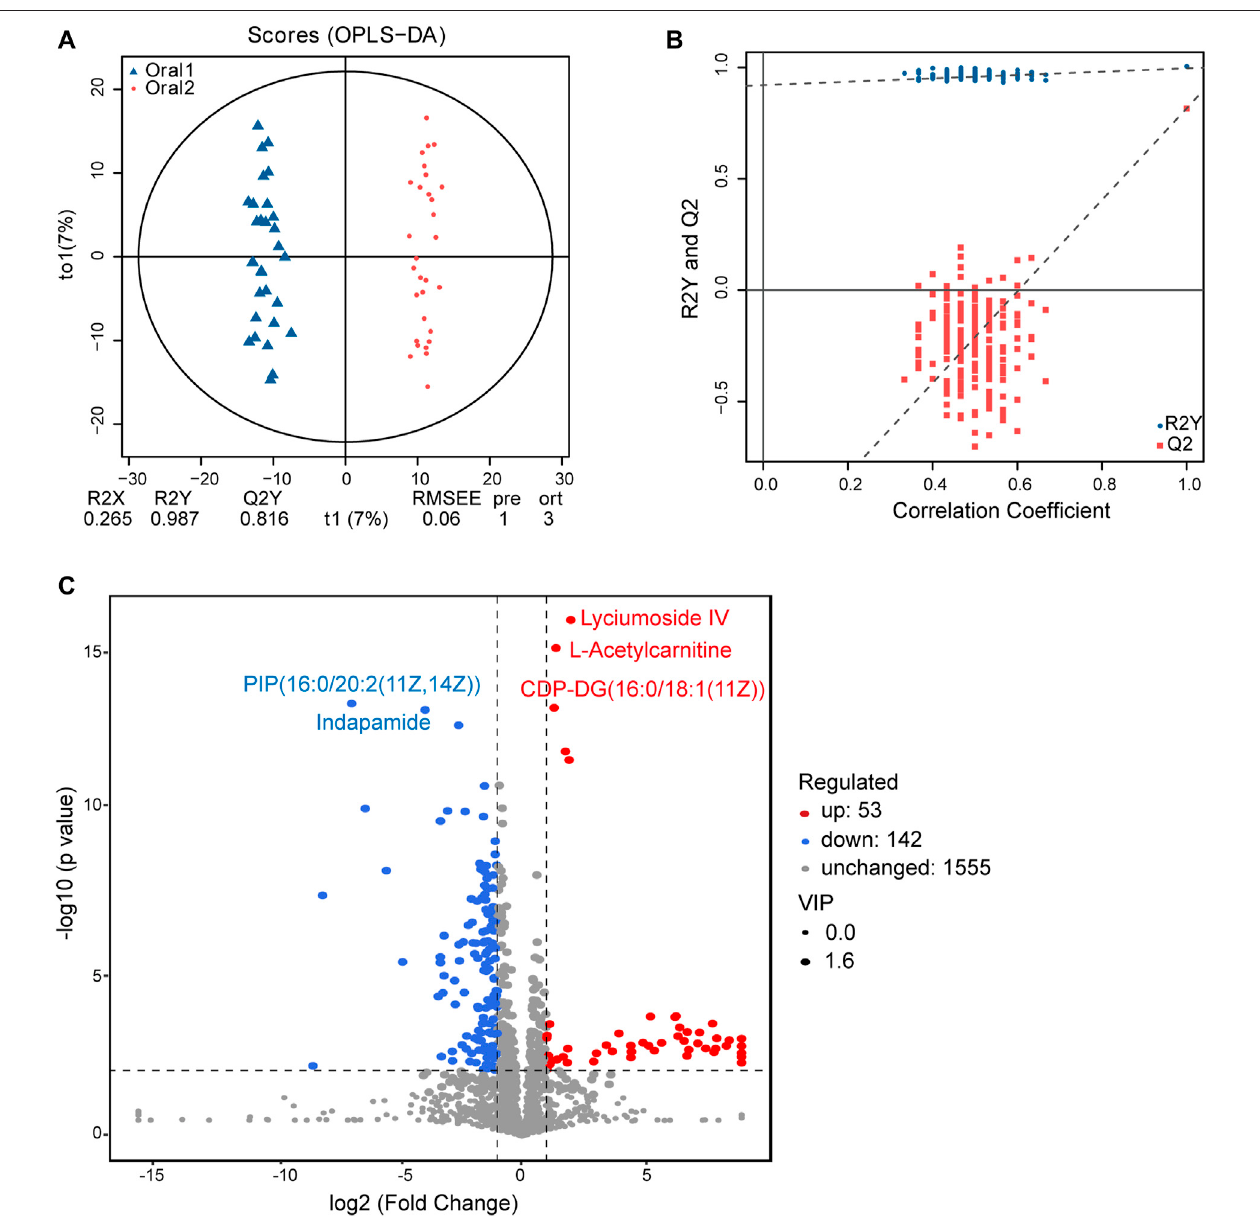
FIGURE6| Fecalmetabolomicsforthequanti fi cationofmetabolitesinthebefore-andafter-administrationgroups. (A) OPLS-DAplotsshowingthespatialdivision between the before- and after-LS capsule administration groups. (B) Permutation plots of the correlation coef fi cient of OPLS-DA models. (C) Volcano plot showing the differentially accumulated [log2 (fold-change) on x -axis] and signi fi cantly changed [ – log10 ( p value) on y -axis] metabolites in the before- and after-administration groups.